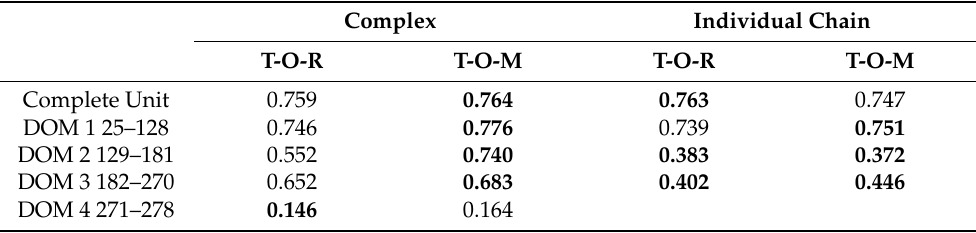
Table 1. RD values for the T-O-R and T-O-M relations for the distinguished domains in the